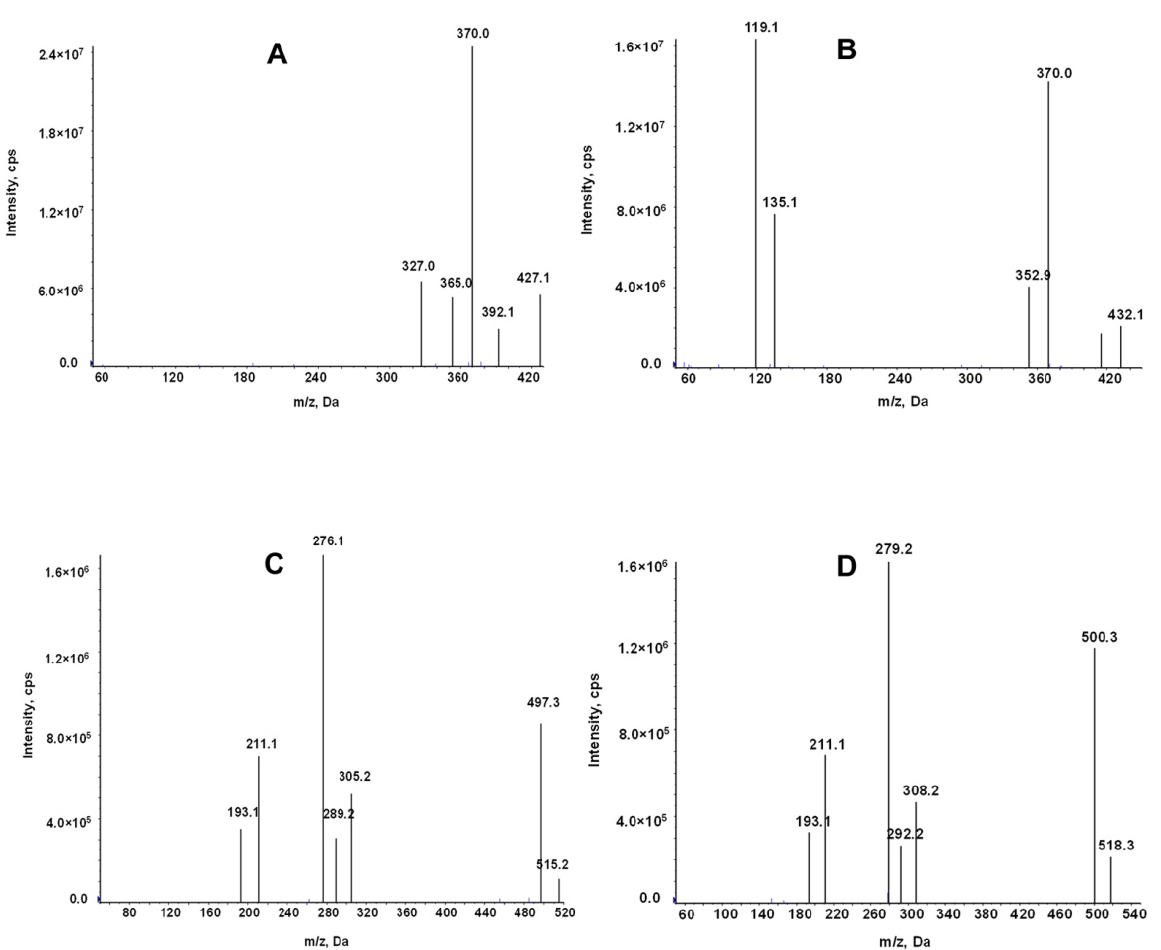
Figure 2. Product ion mass spectrum of LEN ( A ), 2 H 5 -LEN ( B ), TEL ( C ), and TEL-d 3 ( D ).